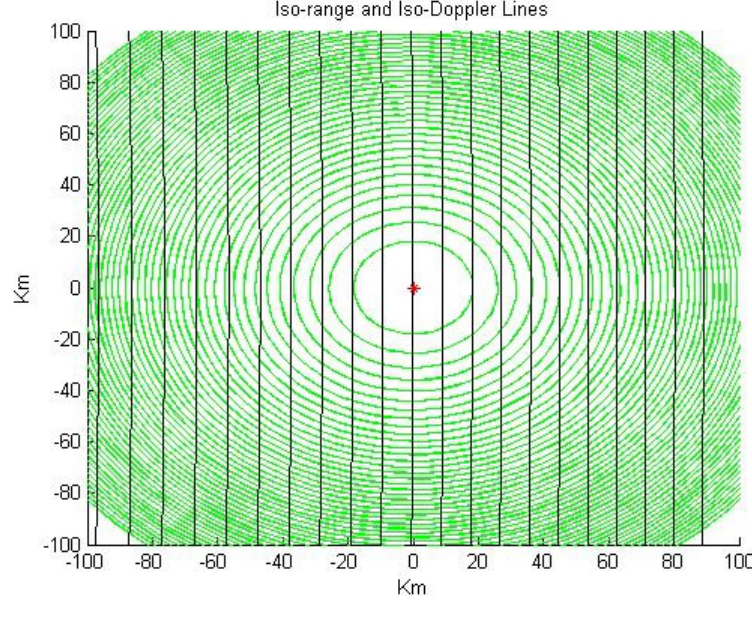
Figure 1. Lines of constant delay and frequency for a GPS L1 reflection received at a 10 degrees incident angle. Constant delay ellipses (green) are at 1 chip intervals (approximately 293 m total path delay), and Doppler parabola spacings (depicted as black straight lines because of the degenerate geometry in this example) are at 100 Hz intervals. Image re-used with permission from